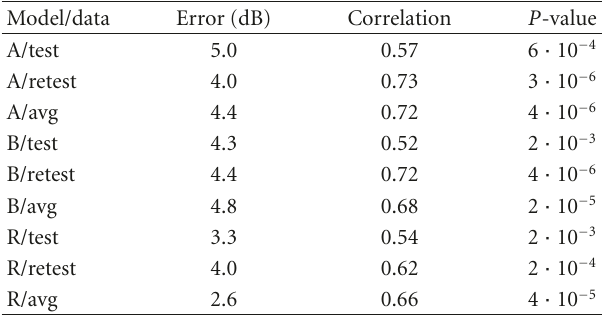
Table 1: SRT prediction accuracy. The median absolute errors and Spearman correlation coe ffi cients with corresponding P -values for SRT predictions using all combinations of models and data sets, including the average of the test and retest predictions (denoted “avg”). The table also includes prediction results from a jackknife linear regression analysis (noted